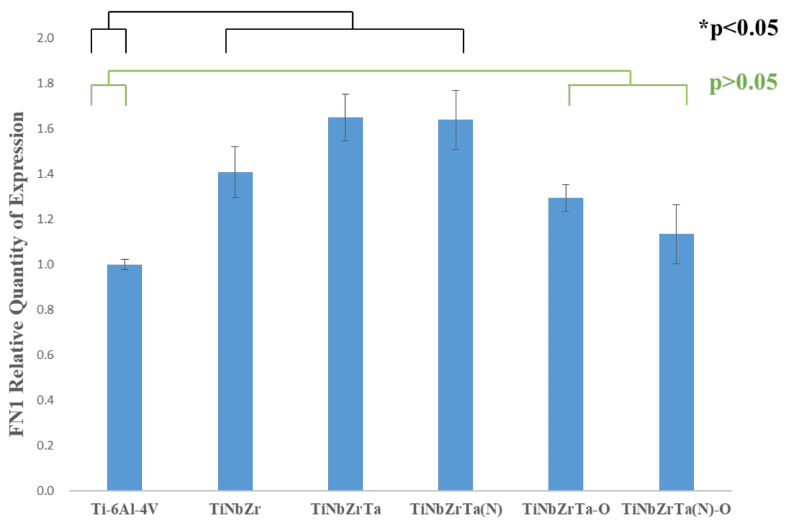
Figure 13. FN1 gene expression of L-929 cultured on uncoated Ti-6Al-4V and TiNbZrTa series films for three days. * represents significance among groups ( p < 0.05); no asterisk represents nonsignificance among groups ( p >